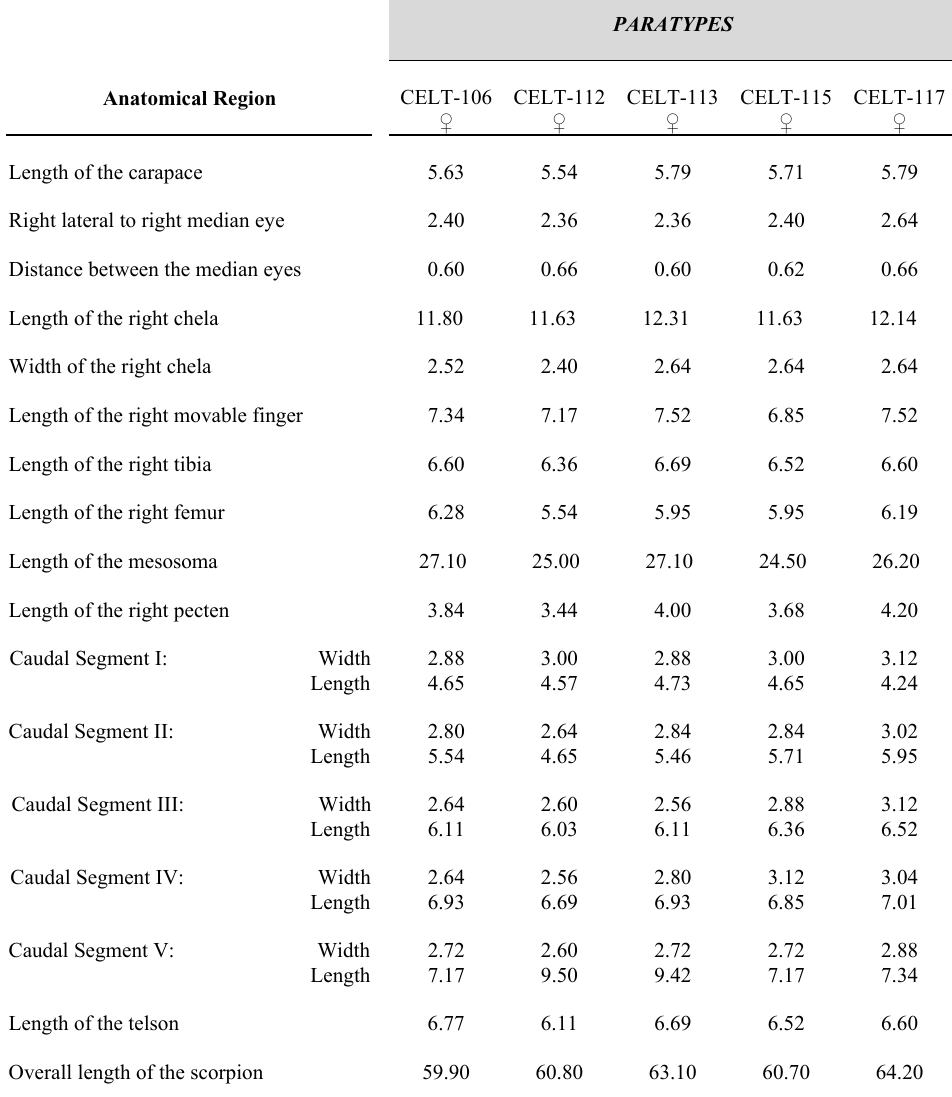
Table 2 . Type series: Morphometric data in millimeters of Tityus gonzalespongai n .